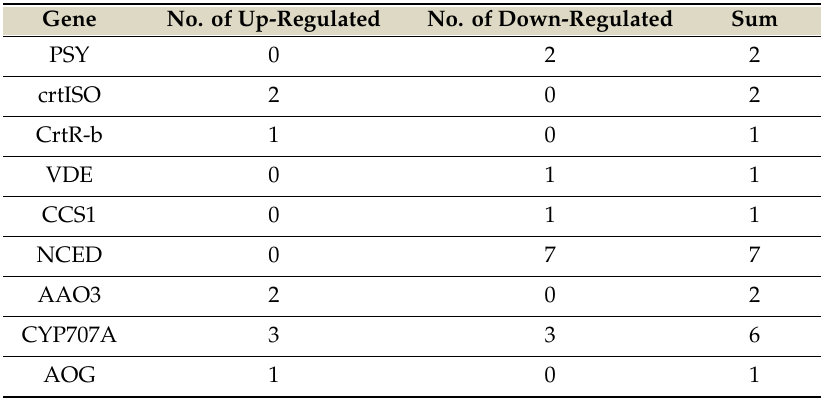
Table 4. Di ff erential expression genes related to Carotenoid biosynthesis under TA treatment.